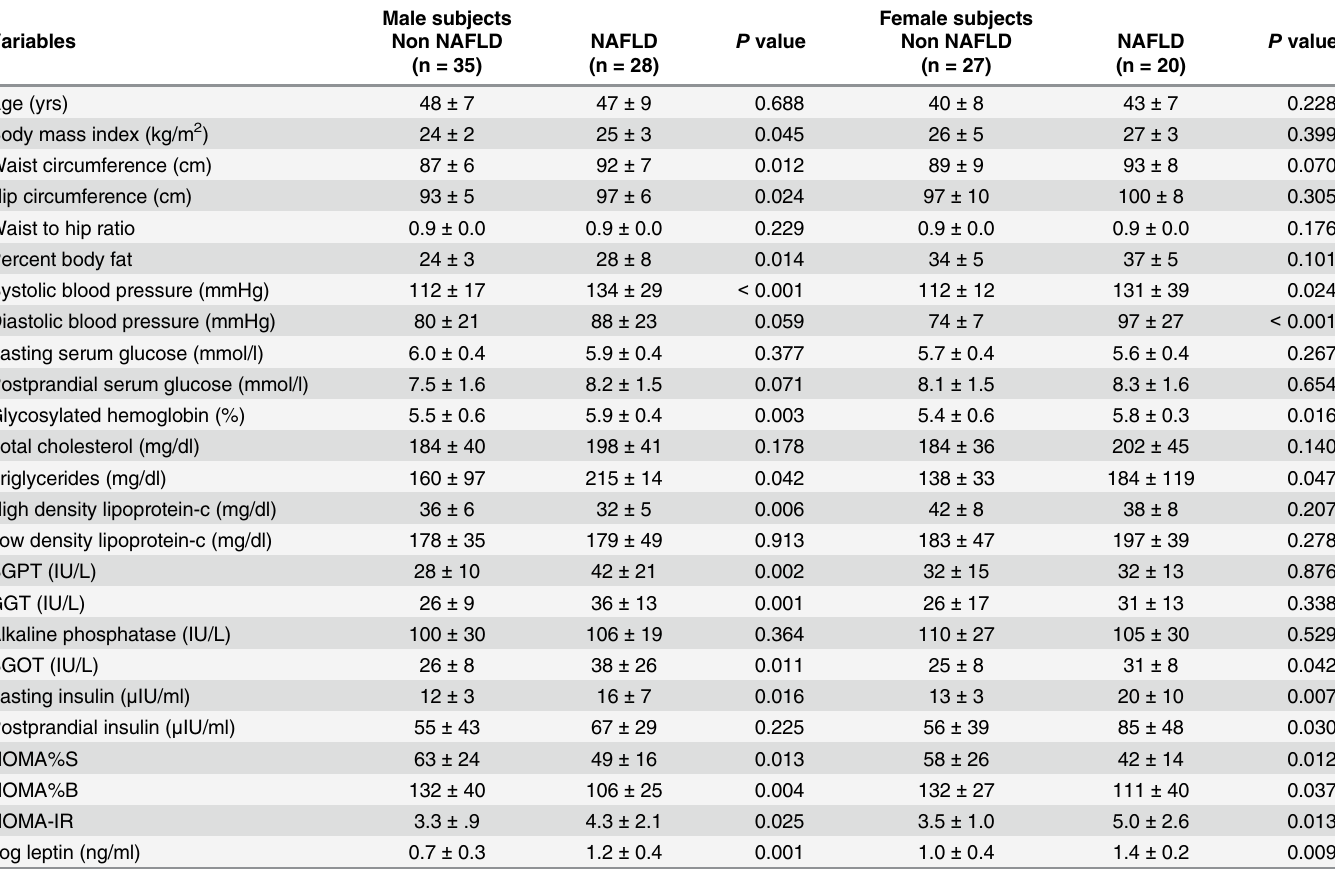
Results are expressed as number (percentage), mean ± SD; n = number of subjects; SGPT, serum glutamate pyruvate transaminase; GGT, gama glutamate transaminase; SGOT, serum glutamate oxaloacetate transaminase; HOMA%B, β cell function assessed by homeostasis model assessment; HOMA%S: insulin sensitivity assessed by homeostasis model assessment; HOMA-IR, insulin resistance assessed by homeostasis model assessment; NAFLD, nonalcoholic fatty liver